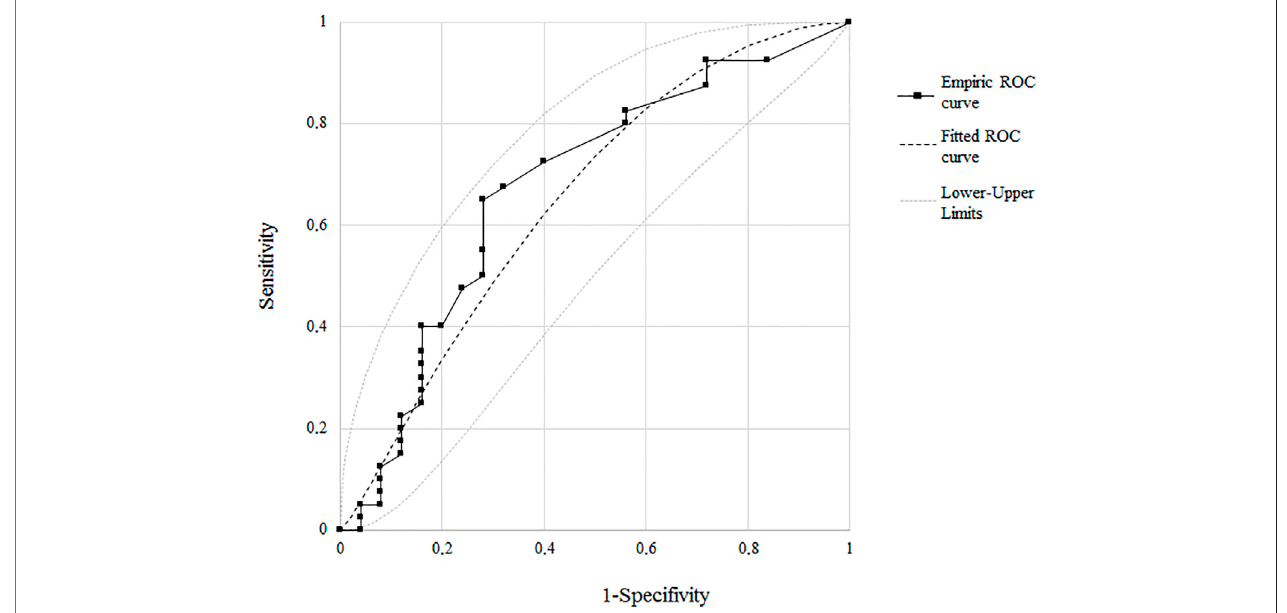
FIGURE 2 | ROC curve illustrating the association between Lp(a) and the severity of carotid atherosclerosis of the cut-off value for carotid atherosclerosis. Sens, sensibility; Spec, speci fi city; AUC, area under the curve.